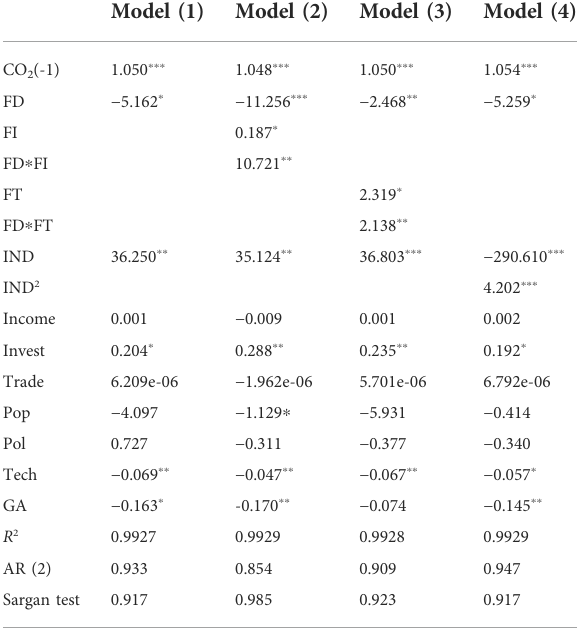
TABLE 3 Results of